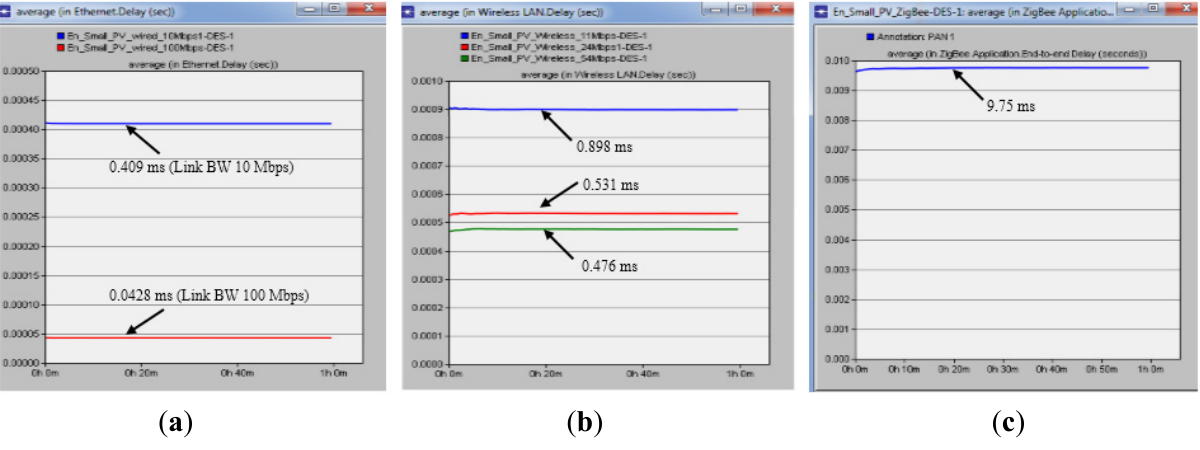
Figure 10. Average ETE delay for PV system. ( a ) Ethernet-based architecture; ( b ) WiFi-based architecture; ( c ) ZigBee-based